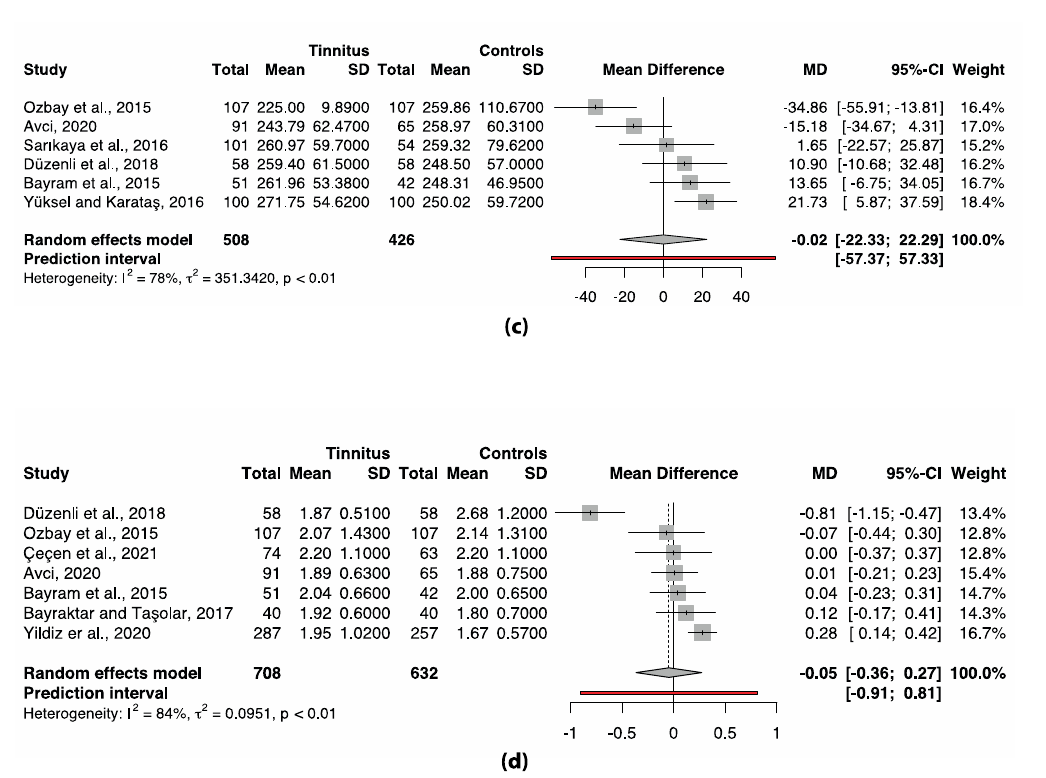
Figure 2. Forest plots of ( a ) MPV, ( b ) PDW, ( c ) platelet count and ( d ) NLR. No significant differences are present in any of the markers. Abbreviations: CI, confidence interval; MD, mean difference; SD, standard deviation.